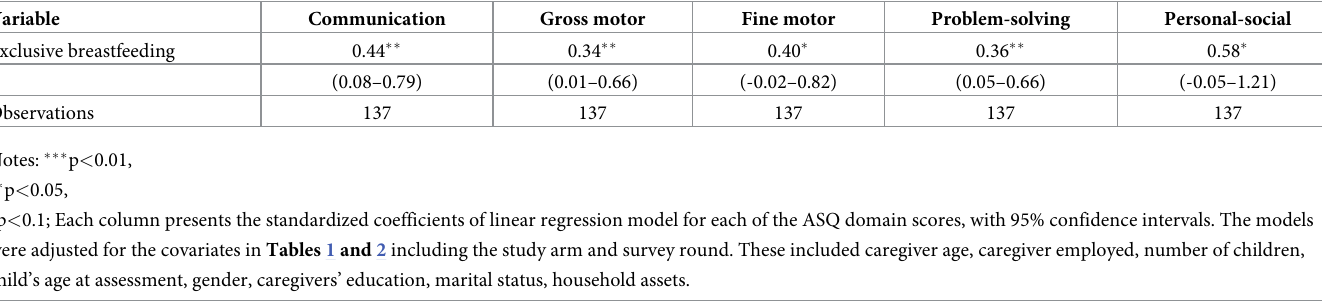
Table 4. Adjusted association between EBF and early childhood development (ECD) domains at 3–6 months (core EBF